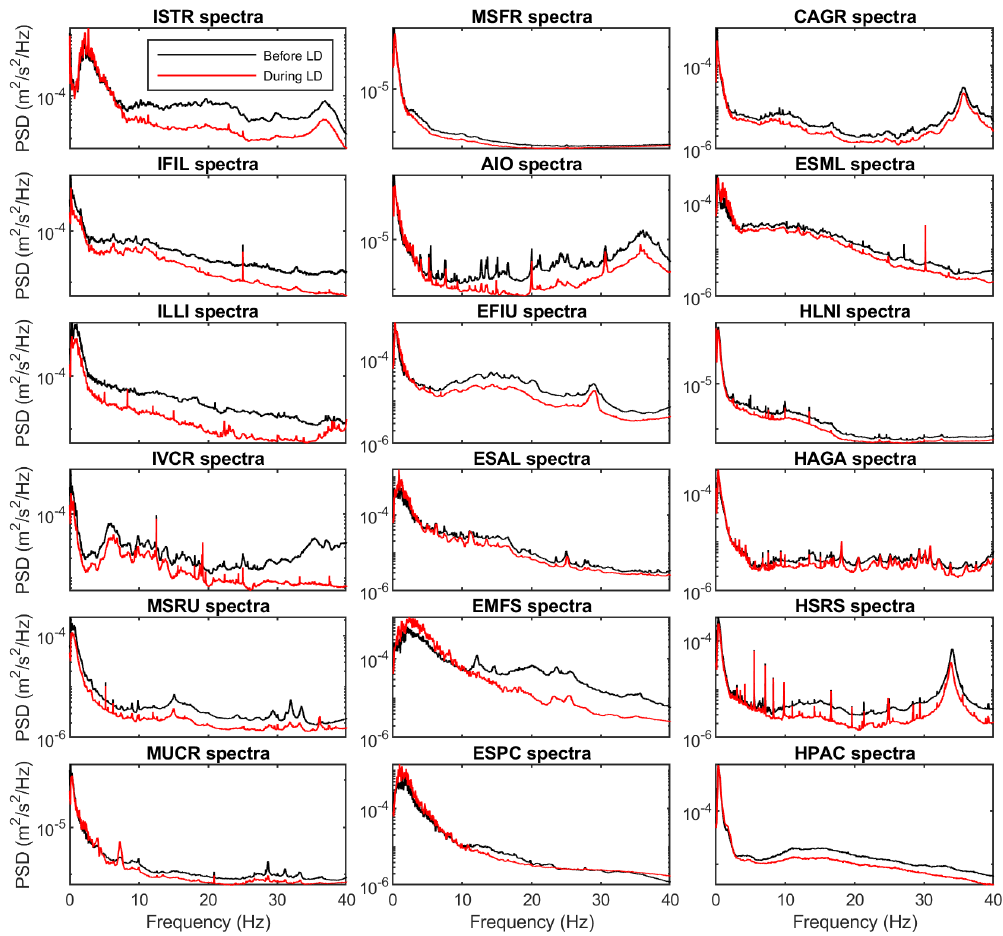
Figure 6. Spectra of the vertical component of the seismic signals recorded during two 20d long time windows, extracted before (black line; 1–20 February) and during (red line; 11 March–1 April) the lockdown. The stations are sorted by decreasing latitude from upper left to bottom